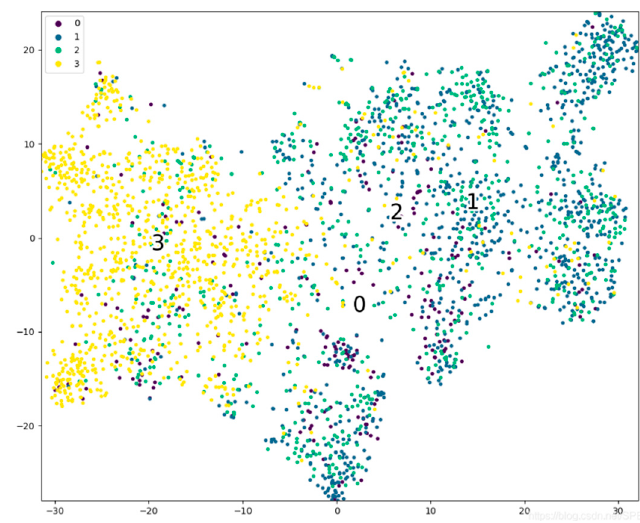
Figure 3. Audio classification results.